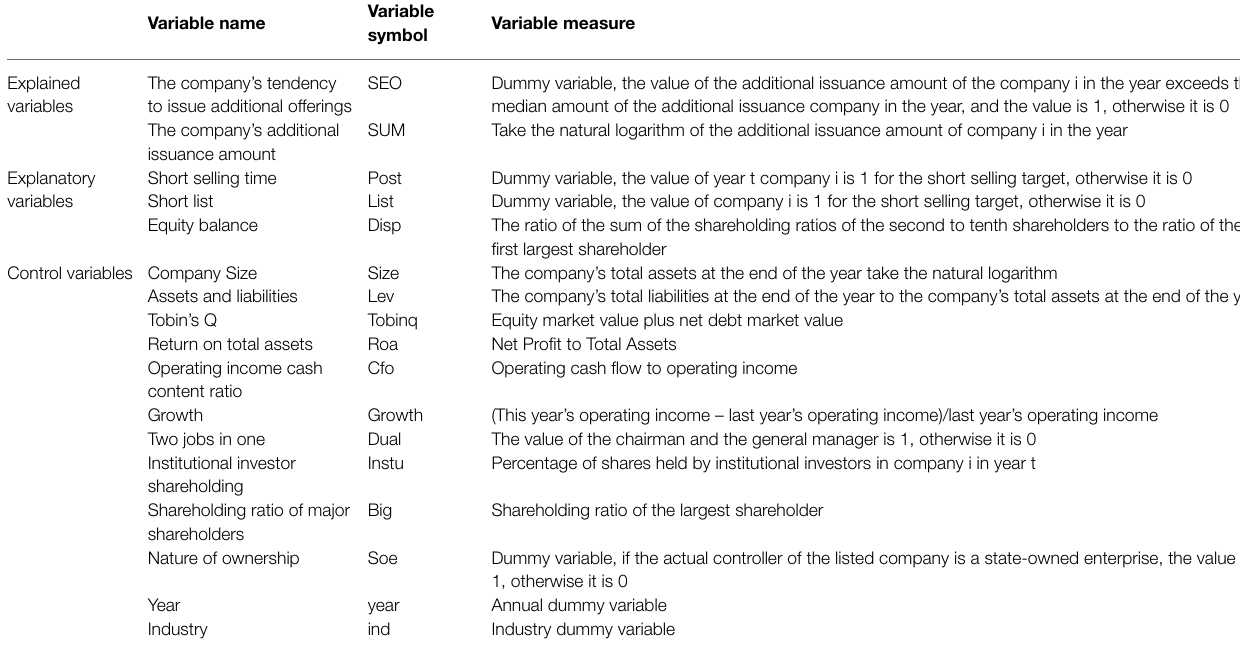
TABLE 1 | Variable definitions.